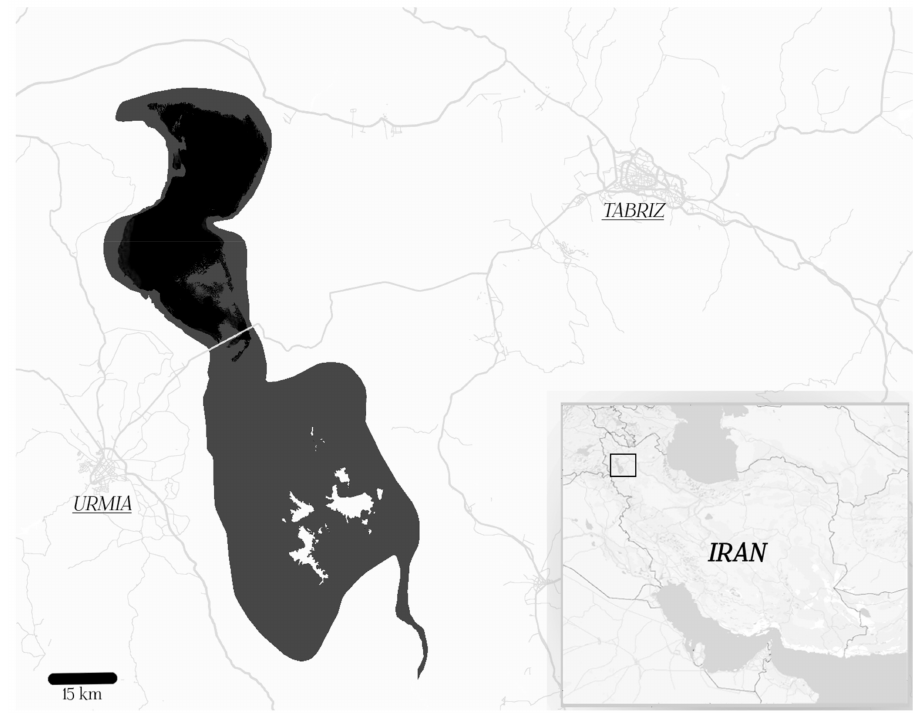
Figure 1. The location of Lake Urmia. The two outlines represent the area of the lake in 1995 (in grey) and in September 2015 (in